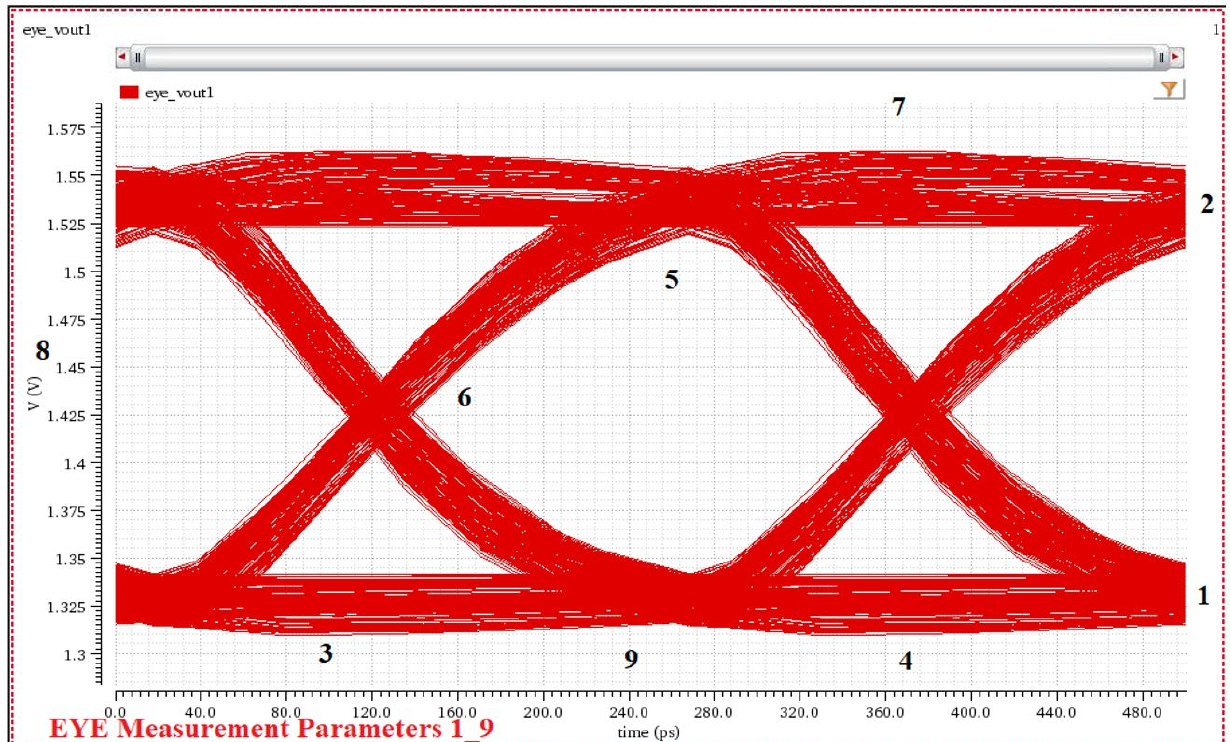
Figure 14. Simulated Eye Diagram. (1) 0 level at 1.33 V; (2) 1 level at 1.52 V; (3) and (4) rise and fall time of 102.2 and 95.1151 ps, respectively; (5) and (6) eye height and width of 118.882 mV and 196.79 ps,